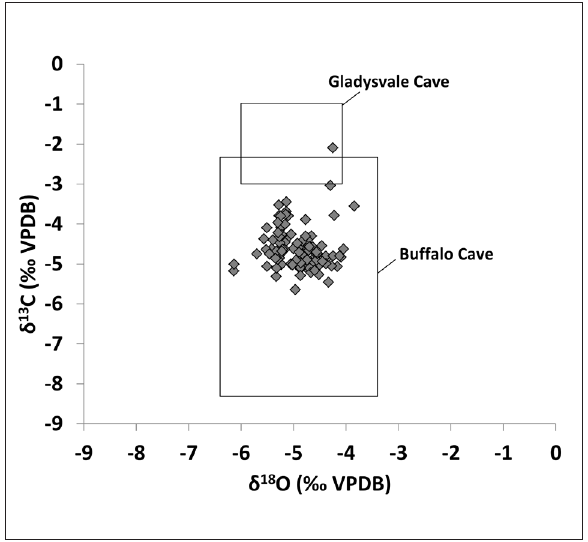
Figure 6: Comparison of stable isotope results for early Pleistocene cave carbonates in South Africa. Stable isotope results from Malapa (rhombus) are shown with reported ranges of results from Gladysvale Cave 10 in the CoH and Buffalo Cave 9 in Makapansgat Valley.